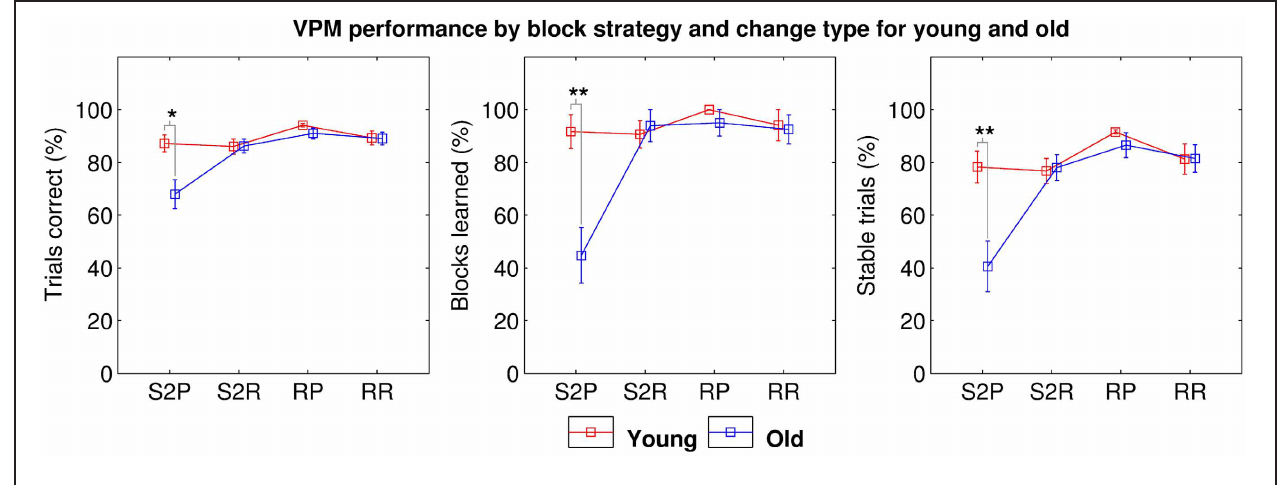
(RR) for young (red) and old (blue) participants, excluding data from first blocks and blocks following unlearned blocks. Significant differences are indicated at the ∗ 0 . 05, ∗∗ 0 . 01, and ∗∗∗ 0 . 001 levels following Bonferroni